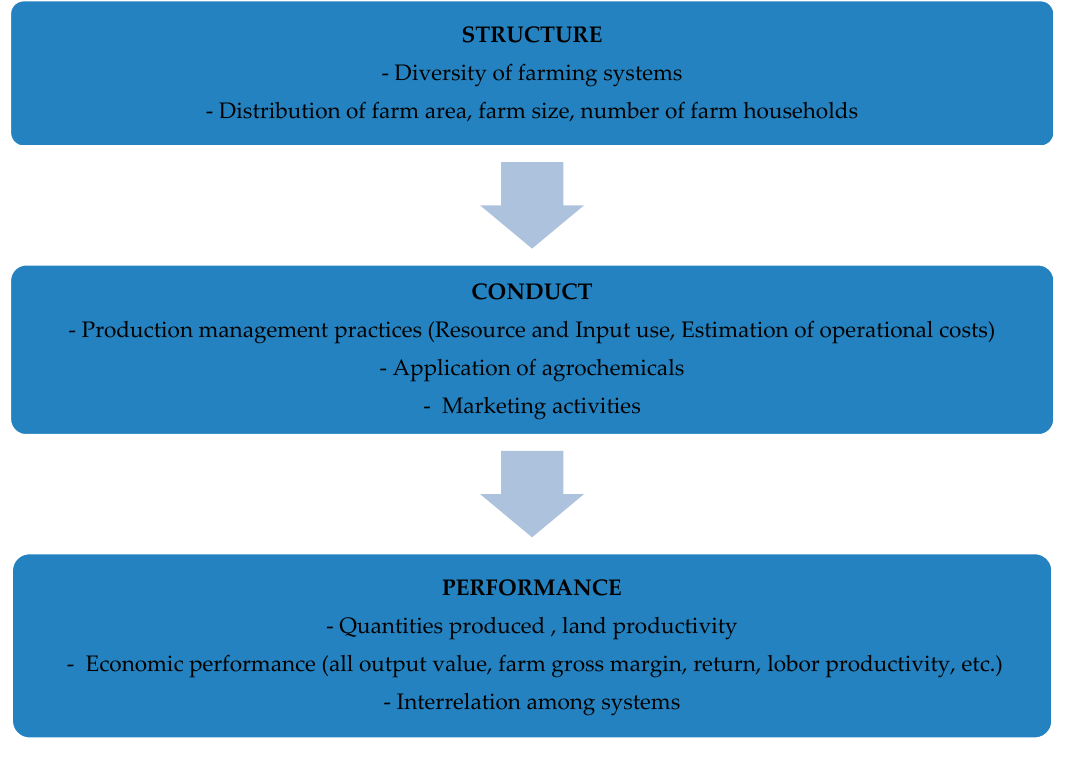
Figure 1. SCP (Structure–Conduct–Performance) framework for farming system analysis.